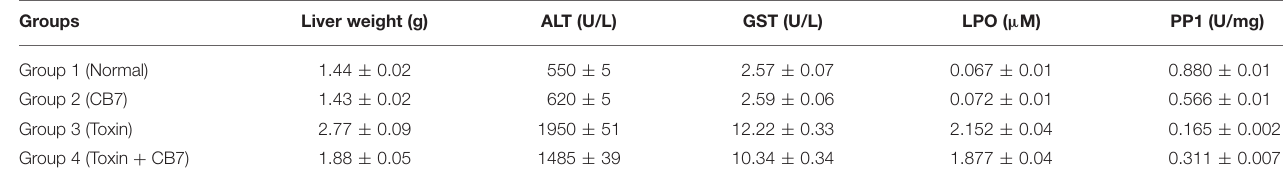
TABLE 1 | Effects of microcystin-LR on the liver function of BALB/c mice in the presence and absence of cucurbit[7]uril (CB7); 10 mice per group ( n = 10). Groups Liver weight (g) PP1 (U/mg) Group 1